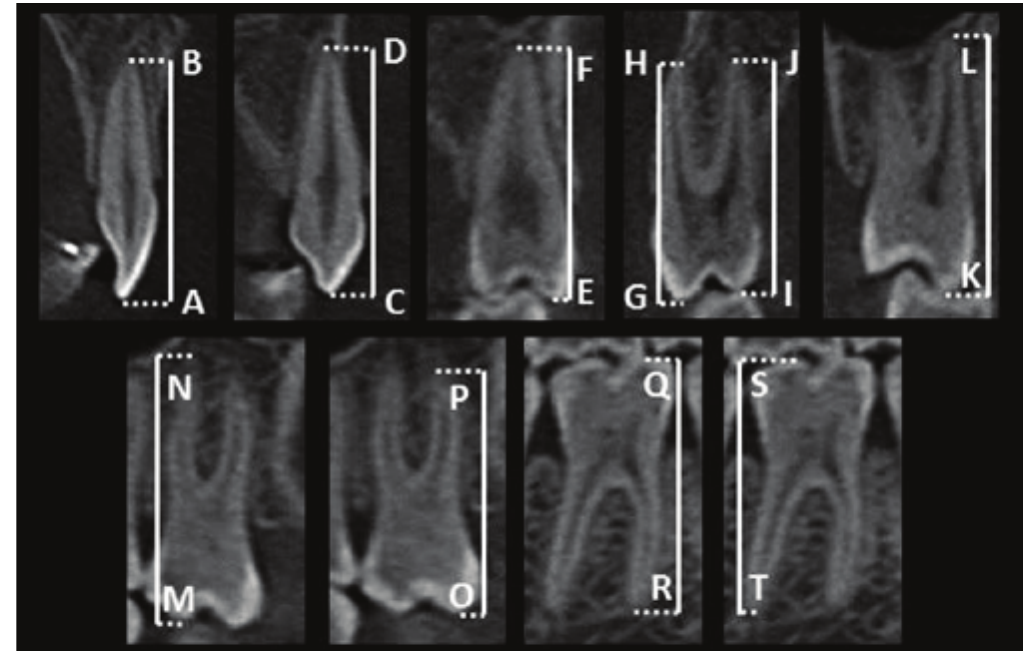
Figure 1. Reference Points Used for Linear Measurement. (Adapted from Castro et al. 14